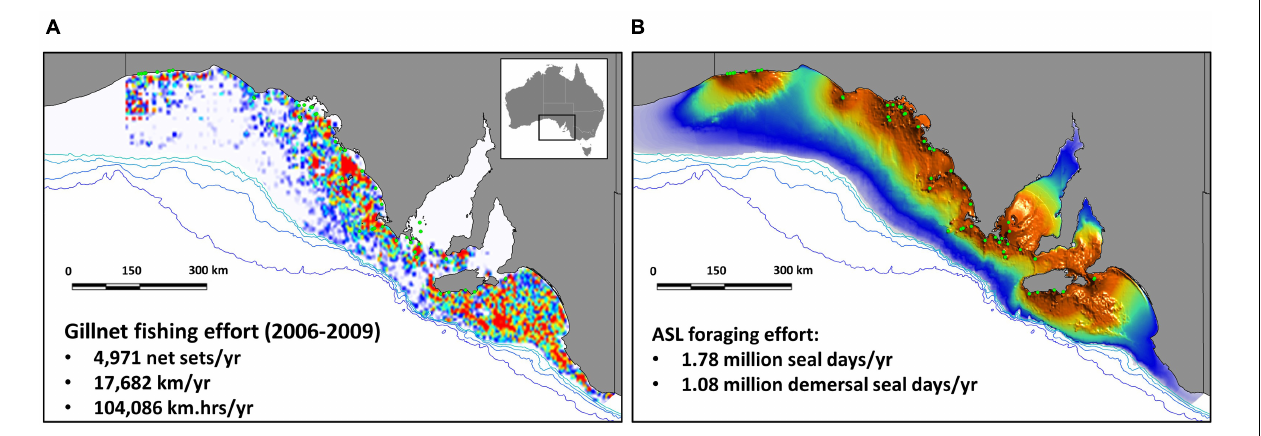
FIGURE 2 | Heat map representing the spatial distribution of gillnet fishing effort off SA, between 2006 and 2009 (inclusive, i.e., 4 years), with average annual effort provided (net-sets, km, and km.hrs) (A) ; species distribution model (heat map) of ASL demersal foraging effort off SA based on estimated abundance in 2010, showing the location of 48 breeding sites (green circles) (B) . Bathymetry lines are indicated from light to dark blue (200, 500, 1000, 2000 m).